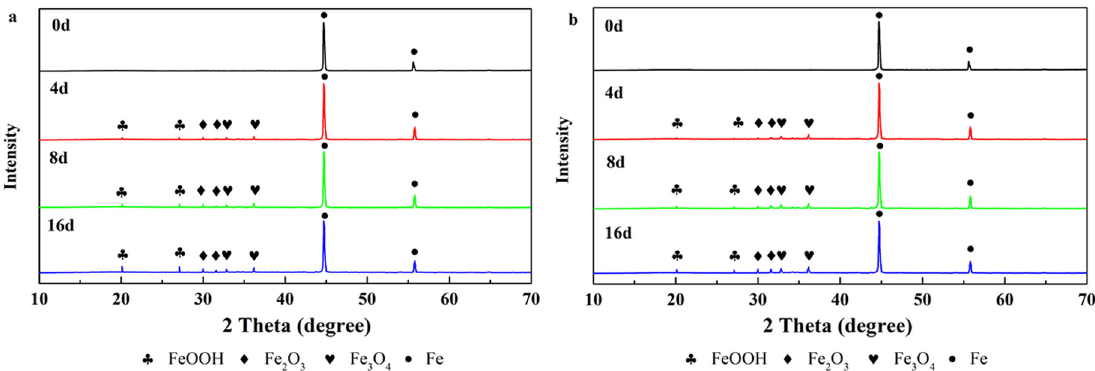
Figure 12: XRD patterns of surface of tinplate samples coated by EL@AR - P 0 ( a ) and EL@AR - P 2 ( b ) during immersion